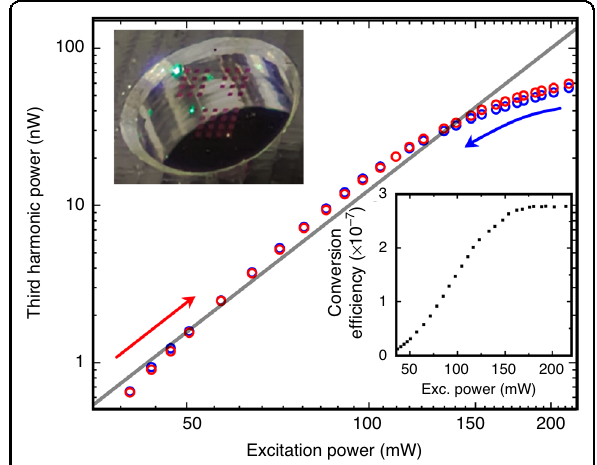
Fig. 5 The third harmonic power as a function of the pump power (log-log scale). Red and blue circles correspond to the gradually increasing or decreasing pump power, respectively. The gray line represents the cubic law. The bottom right inset shows the achieved conversion ef fi ciency as a function of the pump power. The upper left inset presents a photograph showing third harmonic green light emission from the sample for the pump wavelength of 1560